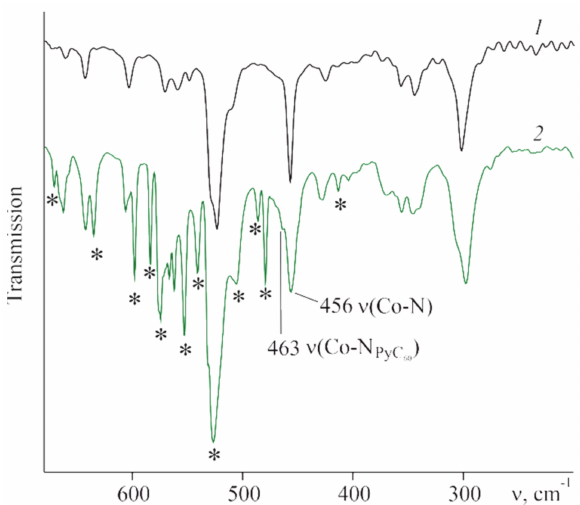
Figure 6. The IR spectra of CoTTP ( 1 ) and (PyC 60 ) 2 CoTTP (2) in CsBr. The peaks corresponding to vibrations of PyC 60 are denoted with asterisks.